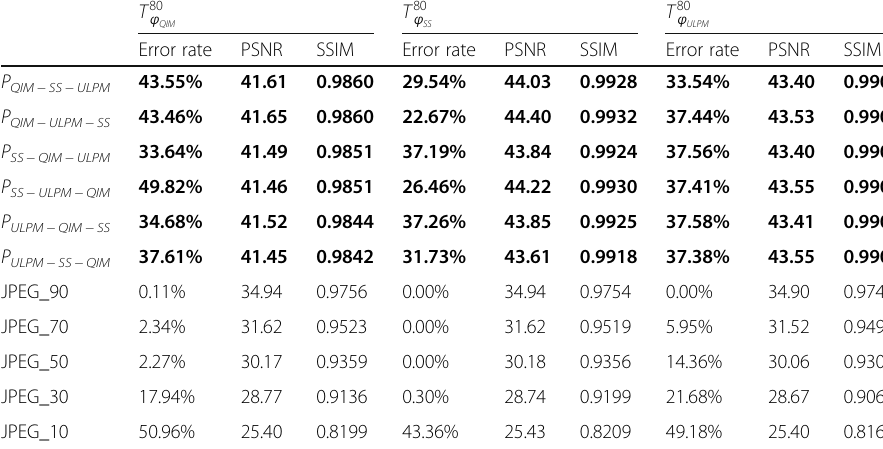
Table 1 Comparisons of JPEG compression and the proposed method in error rate and image quality for watermarked images with payload 80